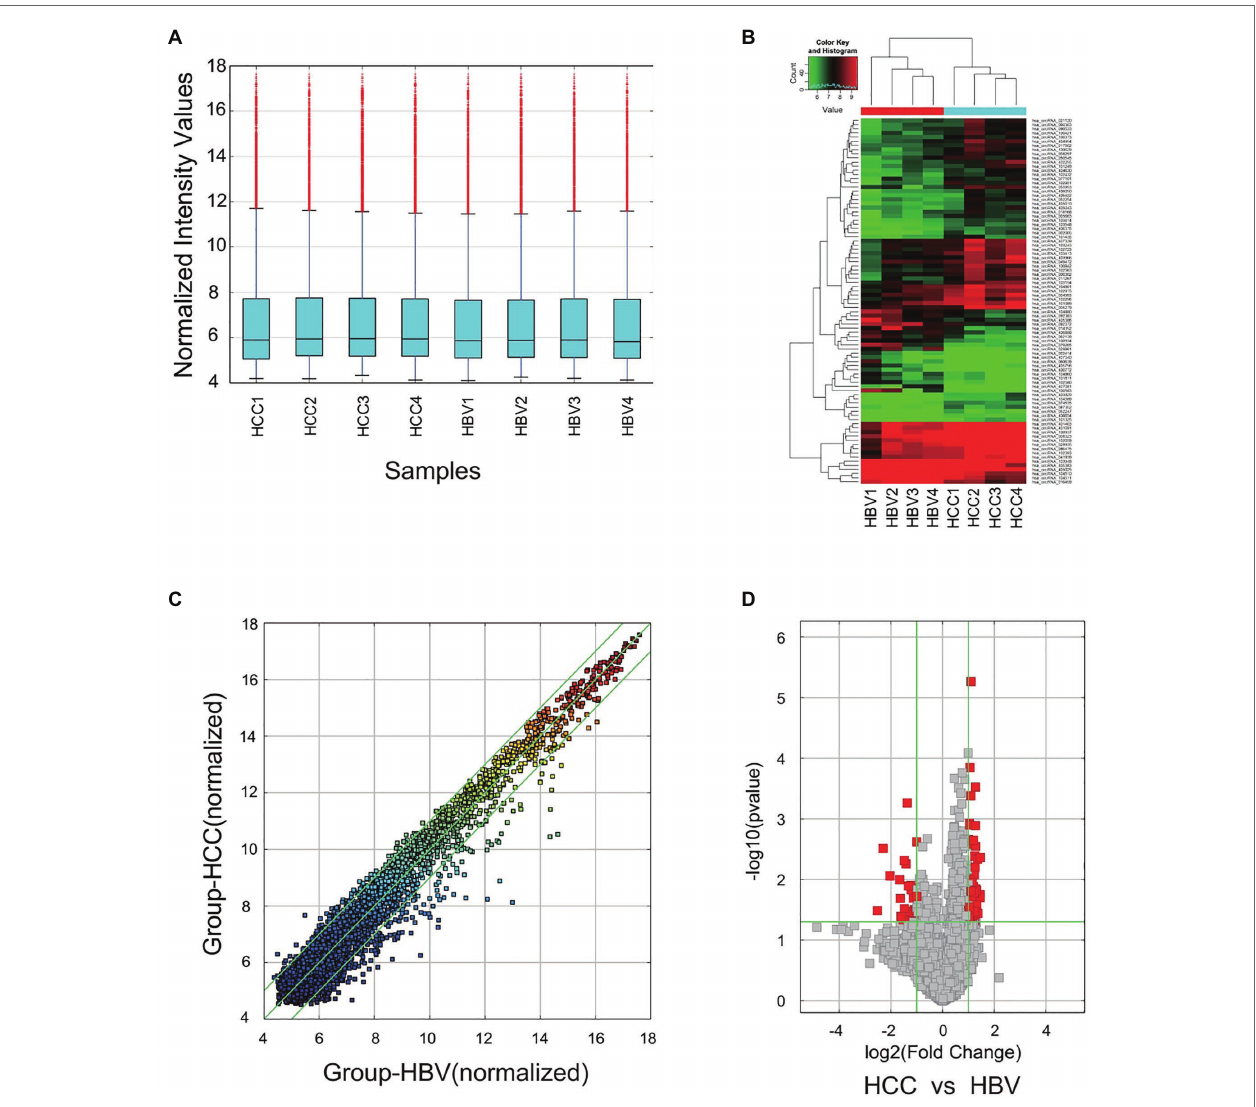
FIGURE 2 | Microarray profiling identified dysregulated circRNAs between chronic HBV and HCC patients. (A) Boxplot of microarray data upon normalization. (B) Differentially expressed circRNAs between four chronic HBV and four HCC patients. Each column represents a sample, and each row represents a circRNA. “Red” indicates increased expression, and “green” indicates decreased expression. (C) The scatter plot assessing the circRNA expression variation between chronic HBV and HCC patients. The circRNAs above the top green line and below the bottom green line indicated fold change >2.0. (D) The volcano plot depicts the difference of circRNAs between chronic HBV and HCC patients. HBV, hepatitis B virus and HCC, hepatocellular cancer. Red points refer to significant dysregulation according to fold change >2.0 and p <